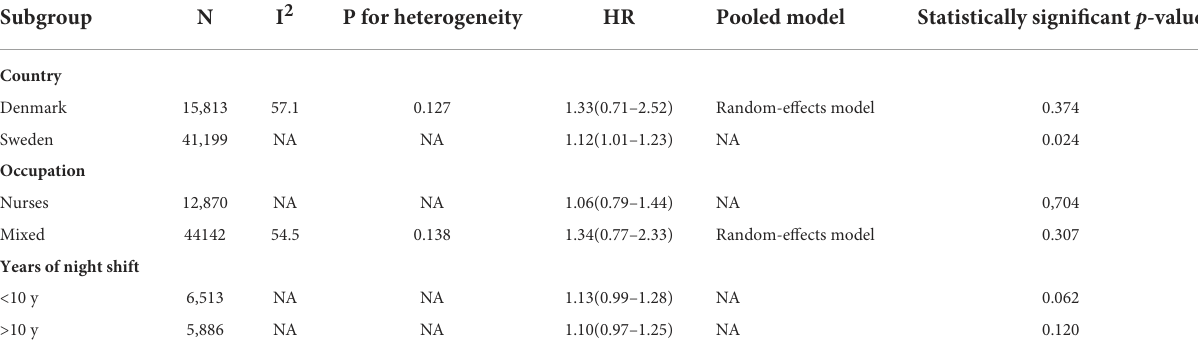
TABLE 4 Subgroup analysis of the association between night shift and risk of dementia. Subgroup N I 2 P for heterogeneity HR Pooled model Statistically significant p -value